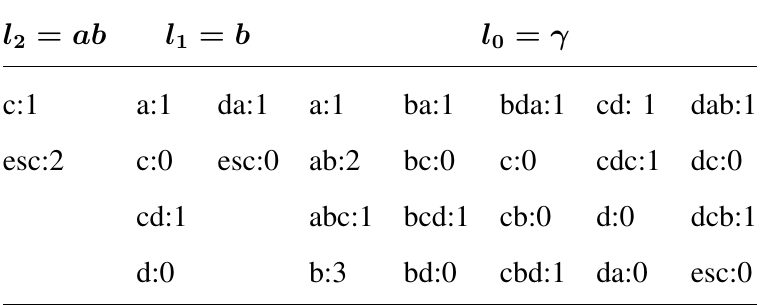
Table 1. Frequency of substrings following the current context for ALZ